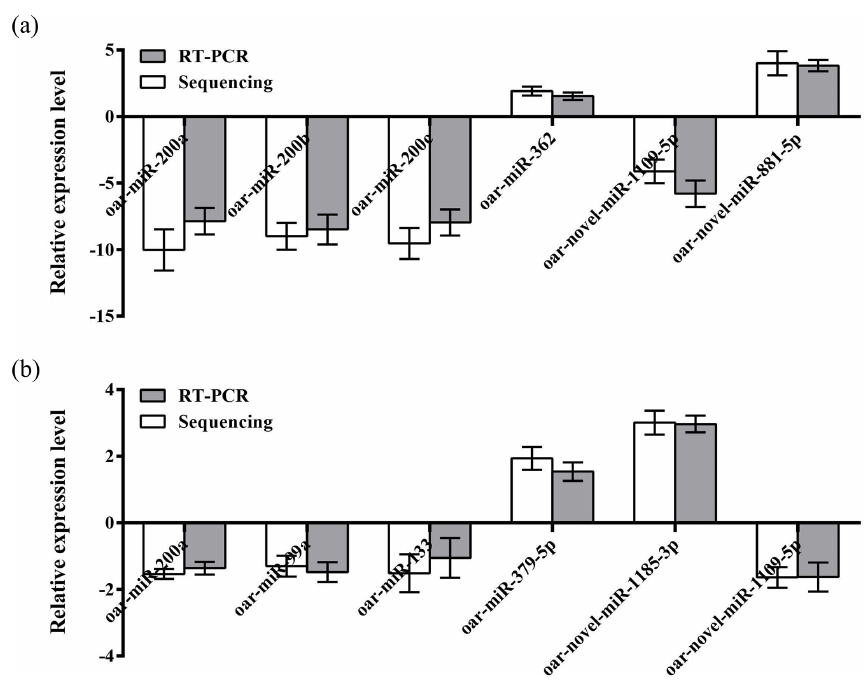
Figure 4. Validation of the Solexa sequencing results in the hypothalamic and uterine libraries. Data are mean ±